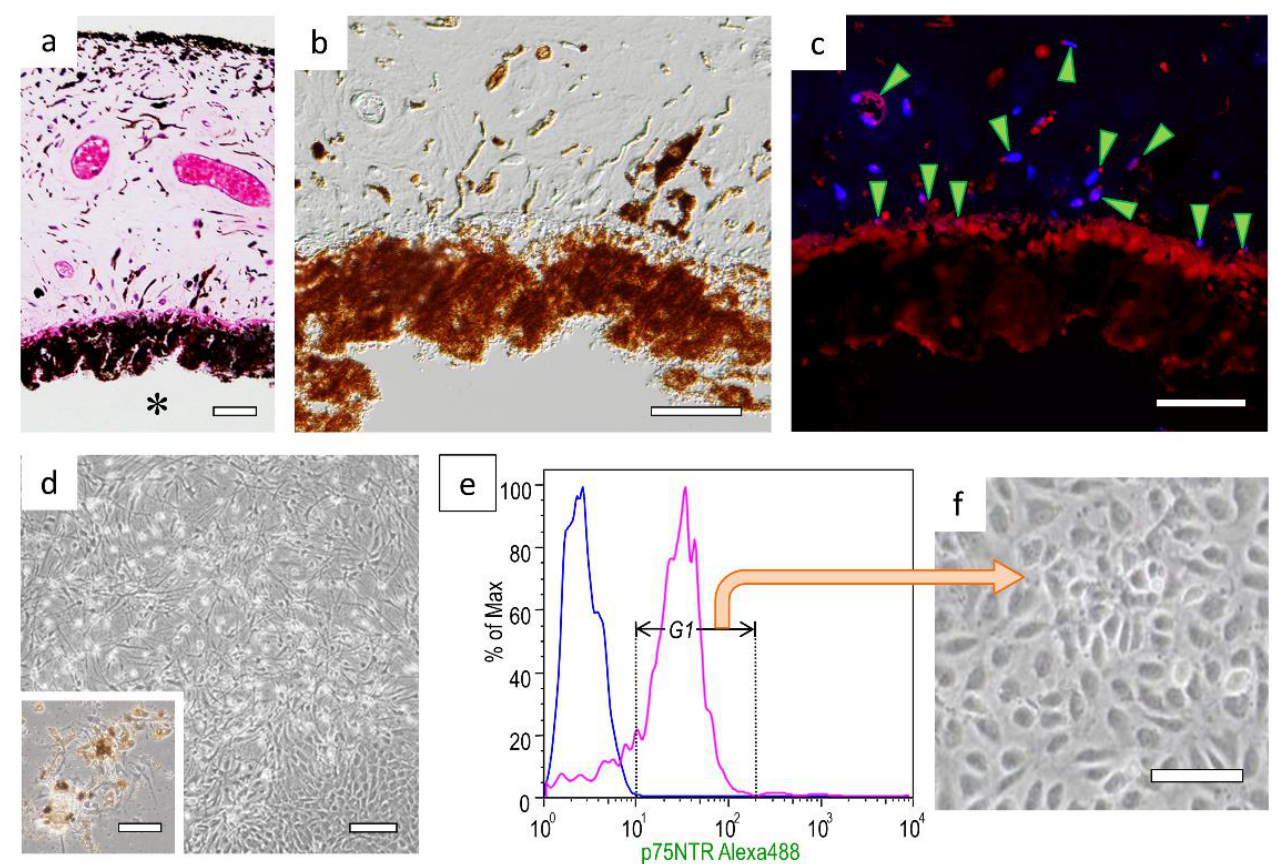
Figure 1. p75NTR-positive cells observed in human iris tissue and cultured cells: ( a ) HE-stained human iris tissue; * The lens side of the iris. ( b ) Differential interference contrast image of iris tissue. ( c ) Fluorescent immunostaining of p75NTR; arrowheads = p75NTR-positive cells. ( d ) Iris-derived cells were cultured for 10 days; the inset shows cells growing from around the pigmented cells on the third day of culture. ( e ) p75NTR-positive cells (region of Gate 1, G1) were isolated with a cell sorter; the blue line represents the histogram of negative cells. ( f ) Morphology of p75NTR-positive sorted cells. Bars in panels ( a – c ), 50 μm; bars in panel ( d )’s inset and panel ( f ), 100 μm; bar in panel ( d ), 200 μm.